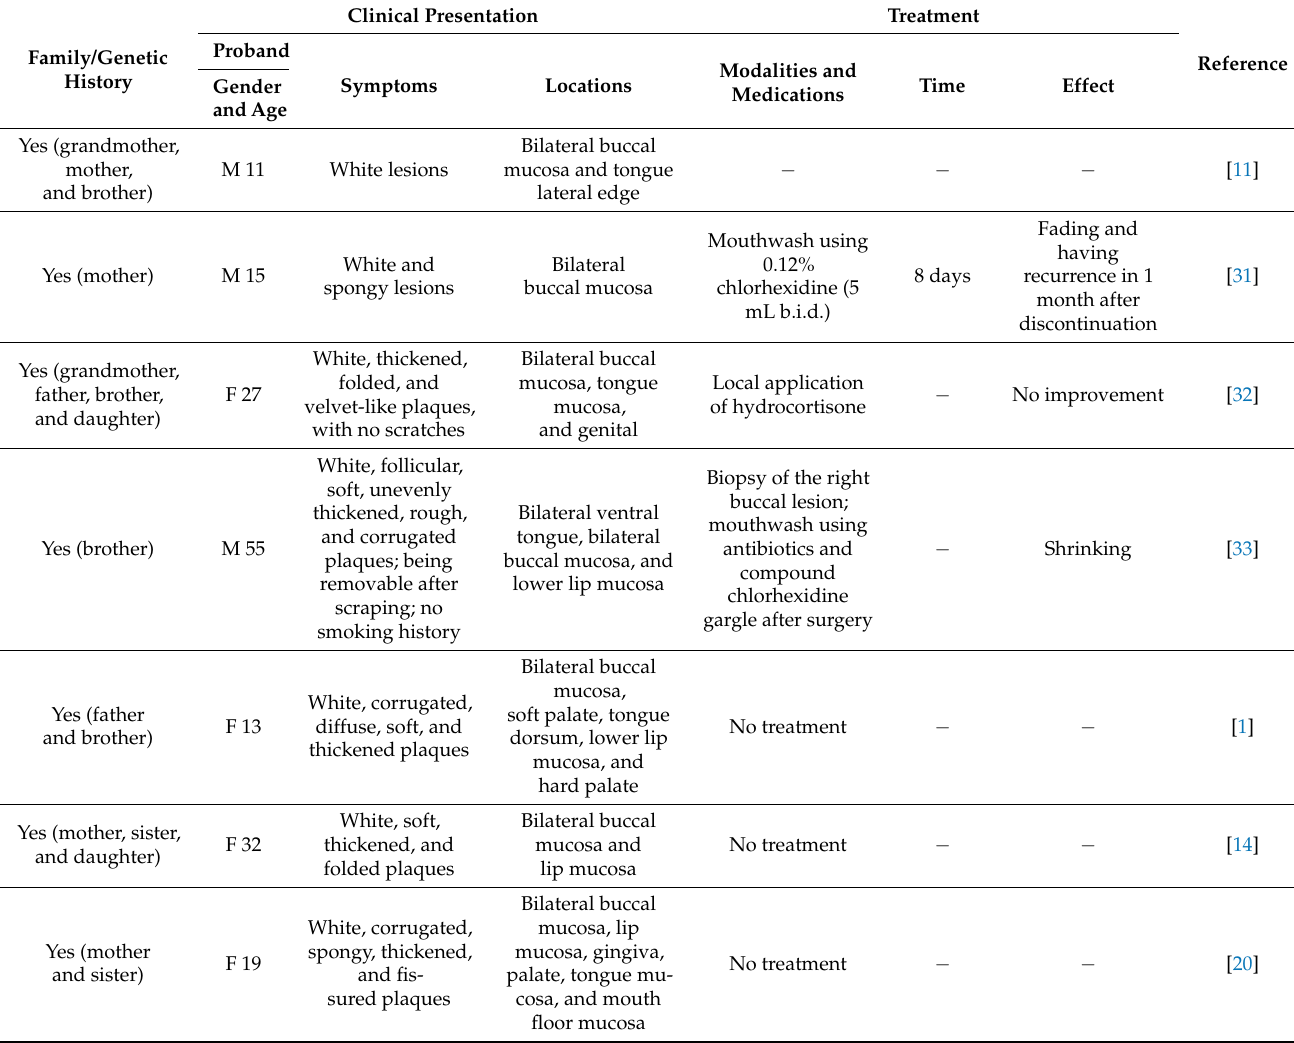
Table 3. Clinical manifestations and treatment modalities of